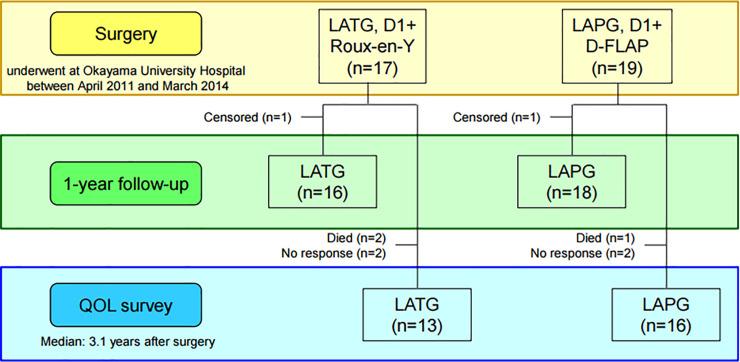
CONSORT diagram.